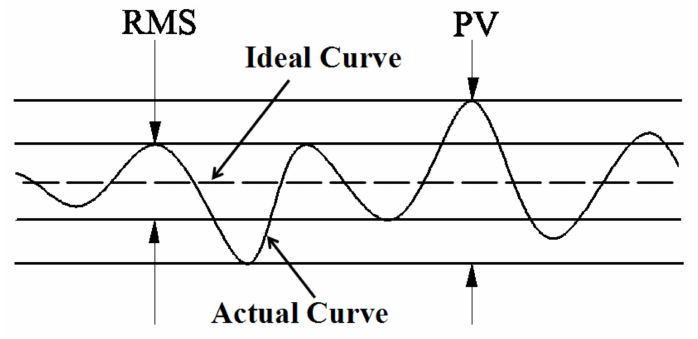
Figure 4. The peak to valley (PV) and the root mean square (RMS) of the actual curve and the ideal curve.